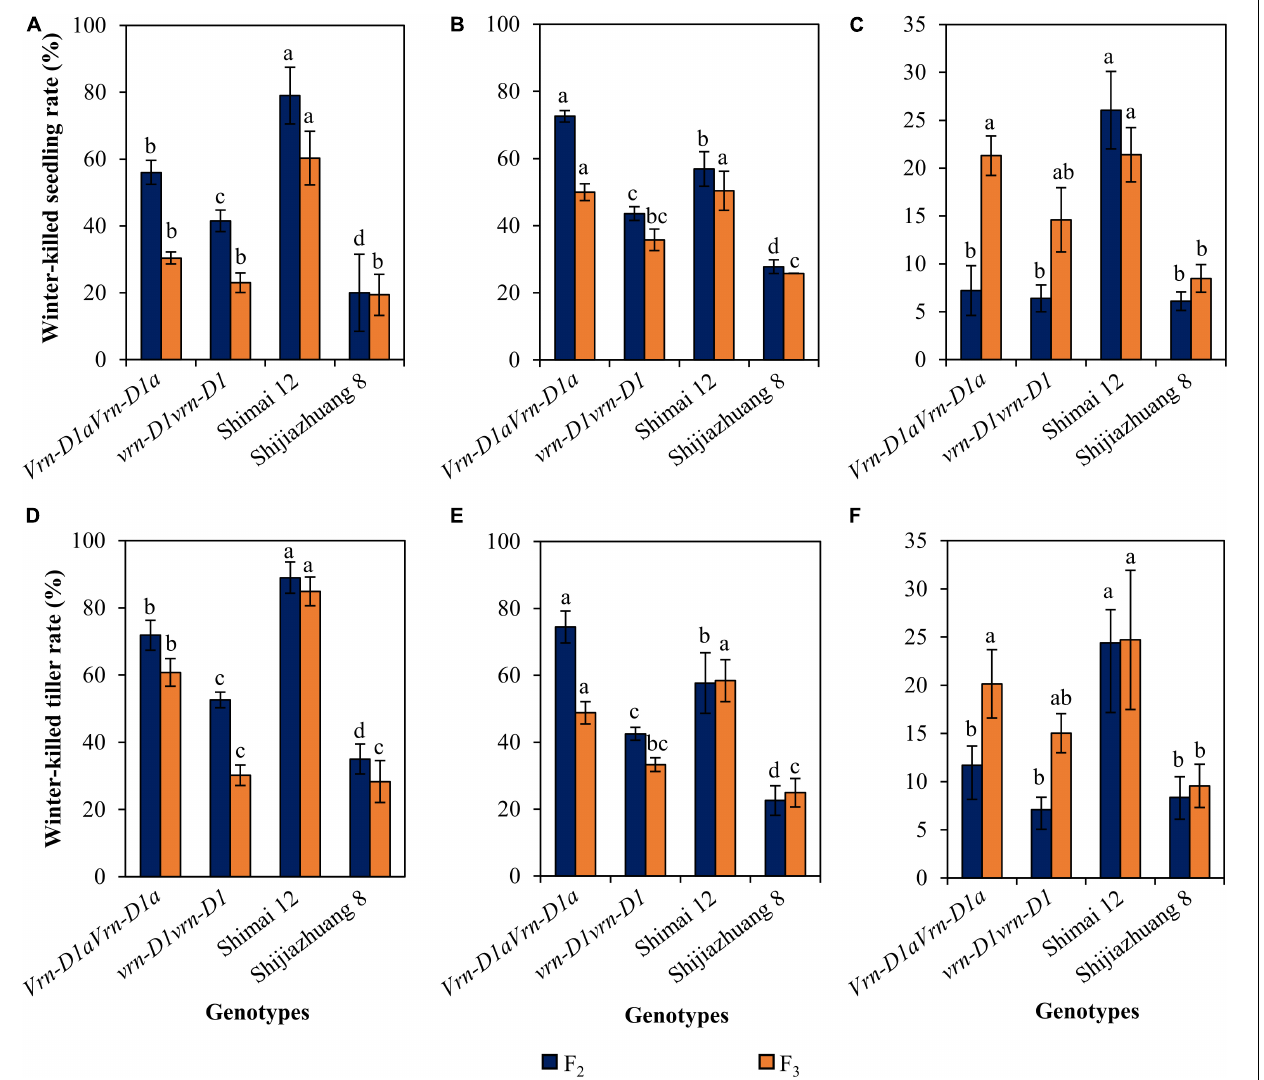
FIGURE 3 | Comparison of winter-killed seedling and tiller rates between genotypes vrn-D1vrn-D1 and Vrn-D1aVrn-D1a in the Shimai 12 × Shijiazhuang 8 F 2 and F 3 populations at 2021SY (A,D) , 2021DX (B,E) , and 2021TG (C,F) . In the F 2 population, the numbers of genotypes vrn-D1vrn-D1 and Vrn-D1aVrn-D1a are 764, 1091, and 1048, and 57, 108, and 102 at 2021SY, 2021DX, and 2021TG, respectively. In the F 3 population, the numbers of genotypes, vrn-D1vrn-D1 and Vrn-D1aVrn-D1a, are 22 and 8, respectively. Multiple comparisons were performed for each trait using the least significant difference (LSD) test and different letters above the error bars indicate significant differences among genotypes and parents at P <